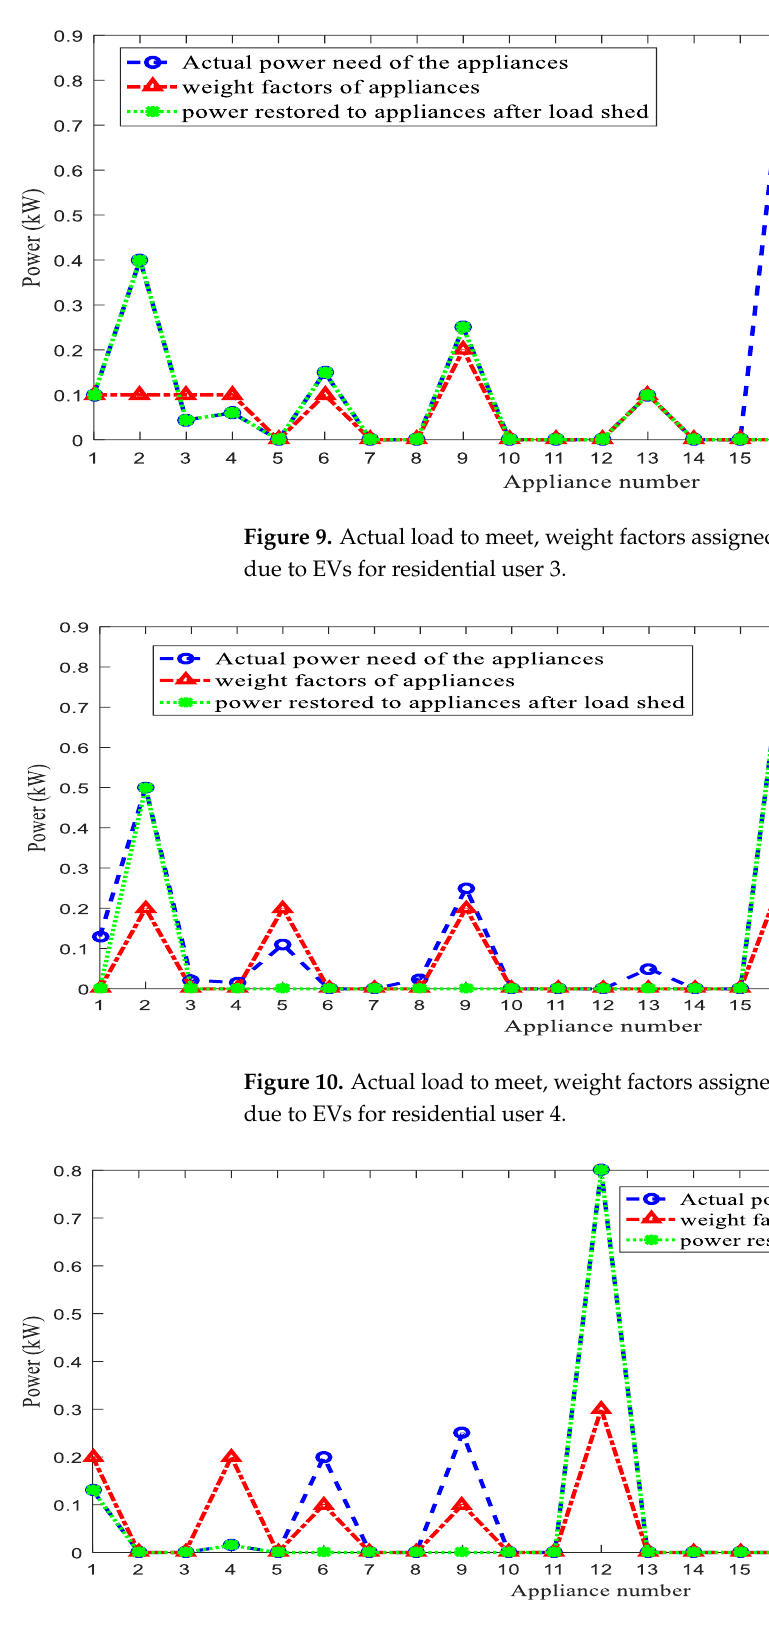
Figure 12. Actual load to meet, weight factors assigned for priority of appliance, and power re- stored due to EVs for residential user 6. Figure 13. Actual load to meet, weight factors assigned for priority of appliance, and power re- stored due to EVs for residential user 7.